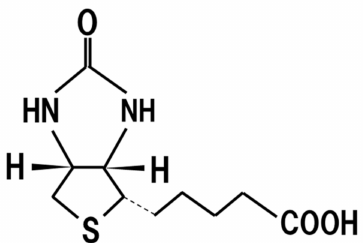
Figure 13. Chemical structure of biotin.